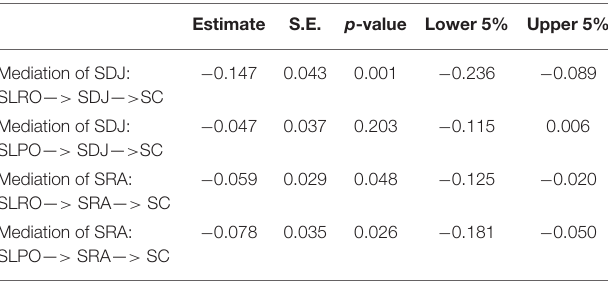
TABLE 4 | Mediating effects